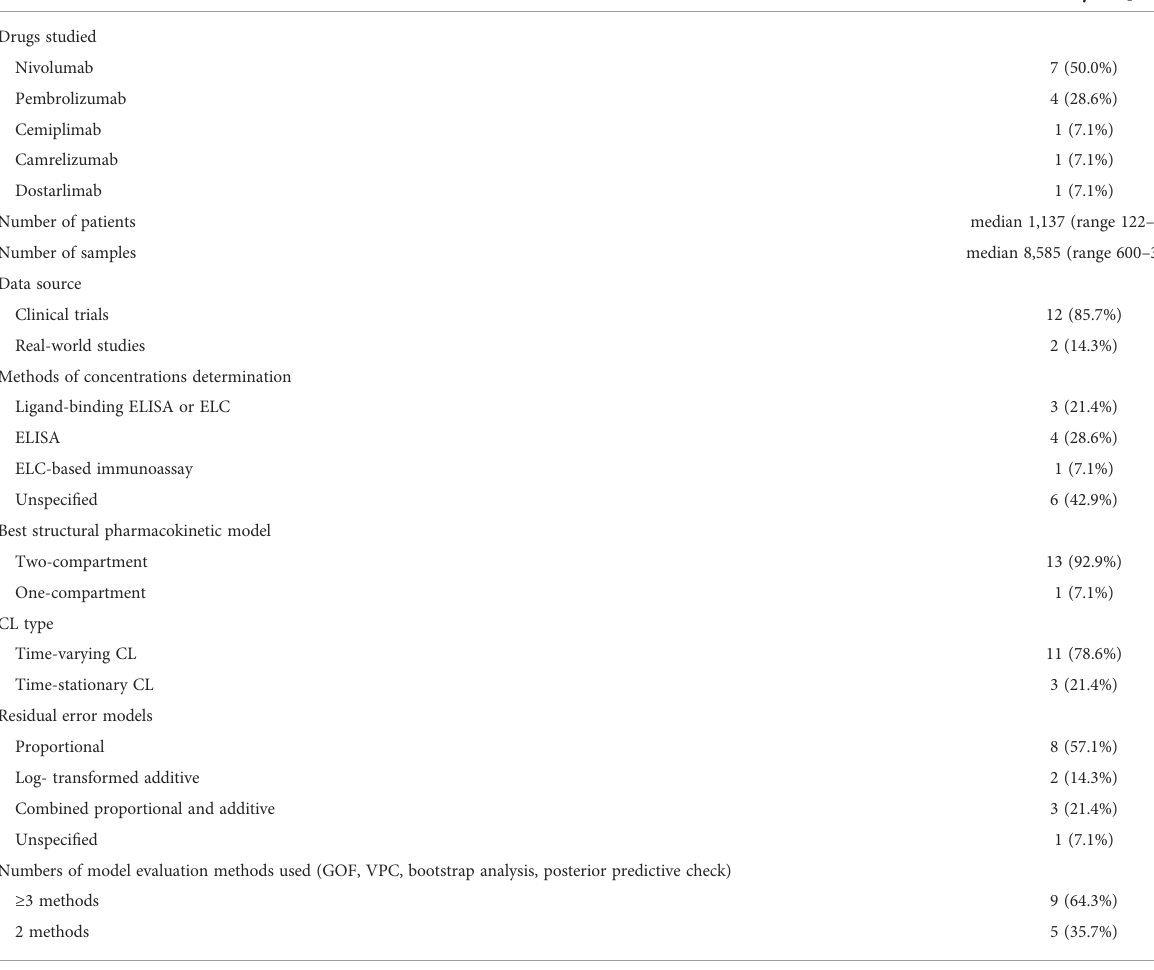
TABLE 1 Characteristics of the included analyses [n =